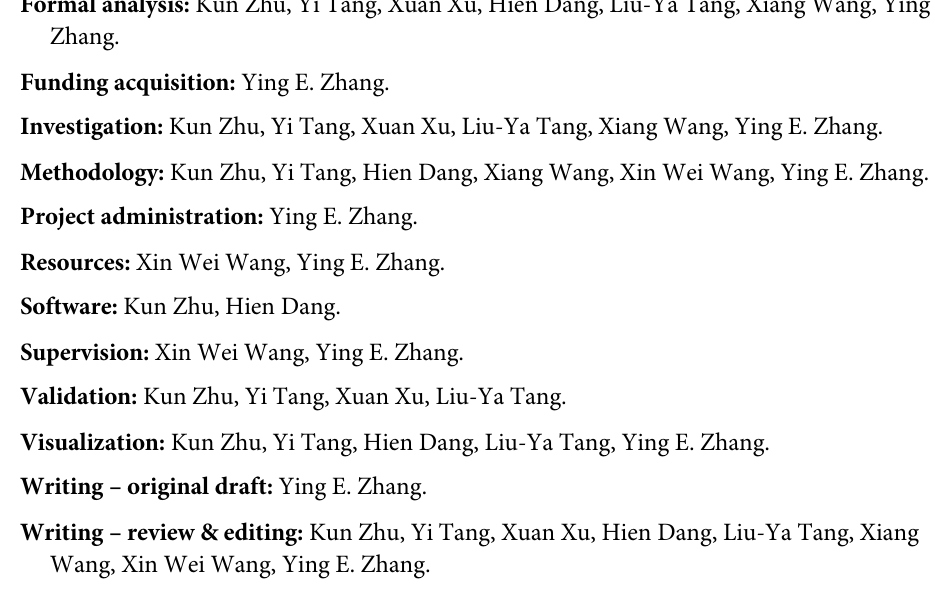
S4 Table. Primer